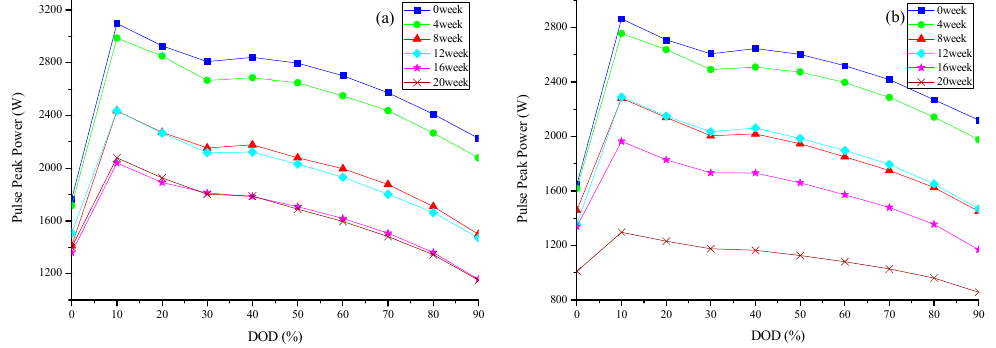
Figure 5. Pulse power capacity vs. DOD for the #1 and #2 cells: ( a ) #1 cell; and ( b ) #2 cell. Brief summary, for both the #1 and #2 cells, the capacity and power loss rate show the same under tested for the same 20 weeks.